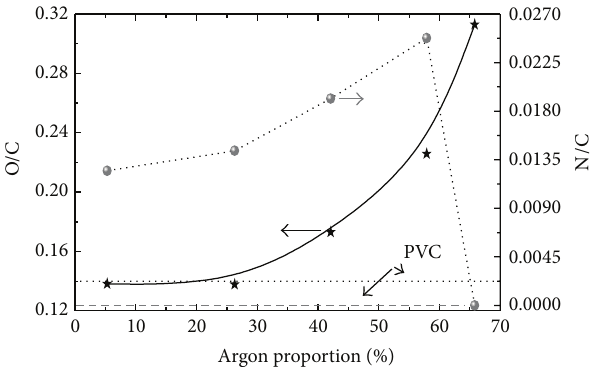
Figure 2: O/C and N/C atomic ratios in the samples as a function of P Ar . Dotted and dashed lines represent, respectively, the O/C and N/C ratios for the uncoated PVC sample.